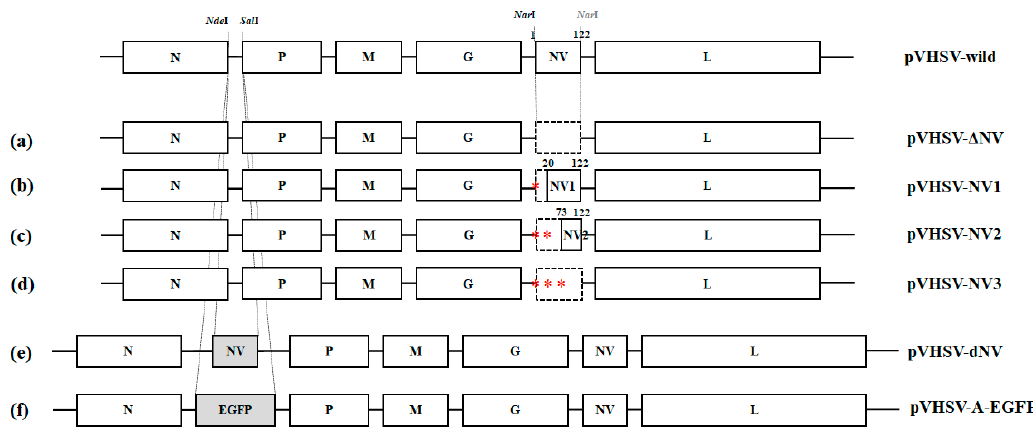
Figure 1. Construction of vectors for NV gene-mutated recombinant VHSVs. ( a ) pVHSV- ∆ NV completely lacking the NV gene from the viral genome and ( b ) pVHSV-NV1, ( c ) -NV2, and ( d ) -NV3 harboring the truncated NV proteins by mutagenesis of the first; first and second; or first, second, and third ATG (M, methionine) codons to TAG codons, respectively. ( e ) pVHSV-dNV harboring an additional NV gene between the N and P genes of the viral genome and ( f ) pVHSV-A-EGFP as a control, harboring the EGFP reporter gene in the same region. * p < 0.05, ** p < 0.01, *** p <